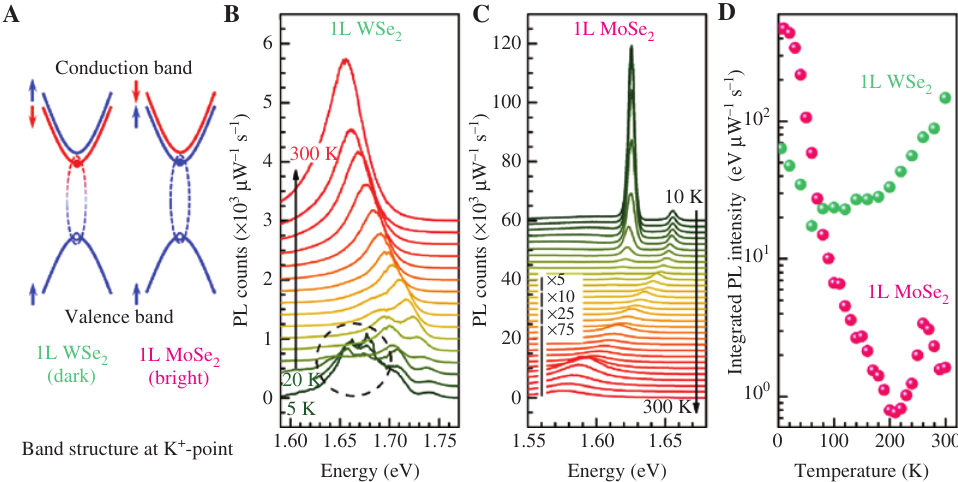
Figure 2: Bright and darkish 1L S-TMDs and their characteristic photoluminescence spectra measured as a function of temperature. (A) Valence band and spin-split conduction band at the K + point of the Brillouin zone for monolayer WSe figuration of the carriers in the respective bands, the ground-state exciton is dark in WSe spectra of (B) 1L WSe [10] and (C) 1L MoSe [11] as a function of temperature up to 300 K, in steps of 20 K and 10 K, respectively. The spectra 2 2 have been shifted vertically for clarity and are also amplified in (C) by factors mentioned in the figure. (D) Integrated PL intensity as a func- tion of temperature depicting peculiar trends for the two materials [10,